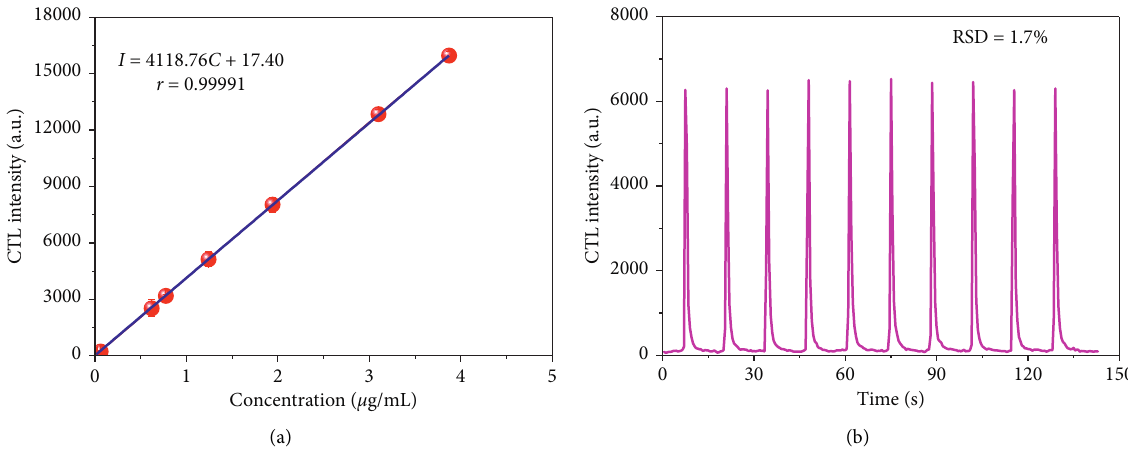
Figure 6: (a) Calibration curve between CTL intensity and concentration of IBD; (b) typical results obtained from ten replicate deter- minations of IBD within